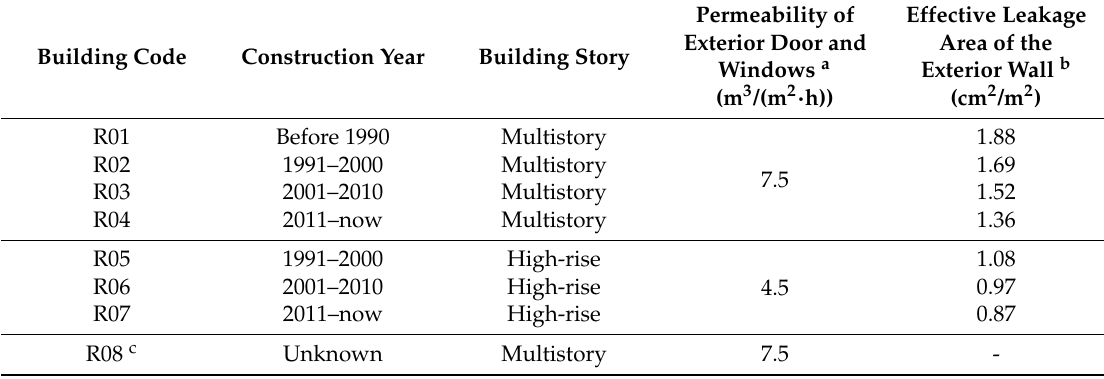
Table 1. Residential building descriptions and building input parameters of the